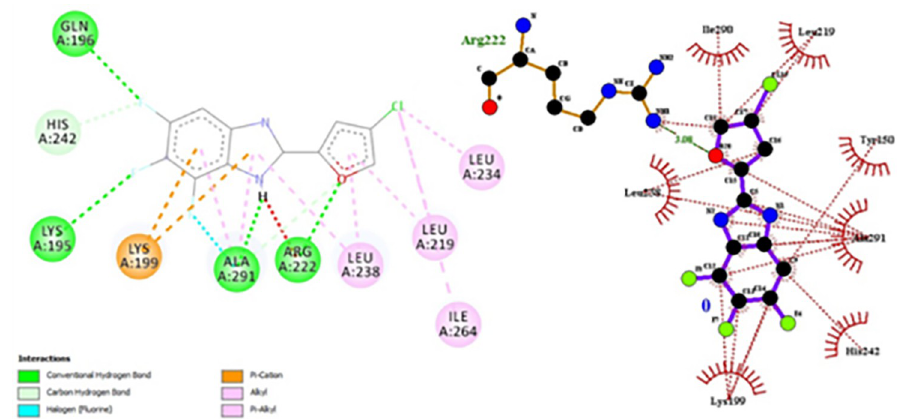
Fig 9. 2D depiction of docking of 5e in the active site of human serum albumin .